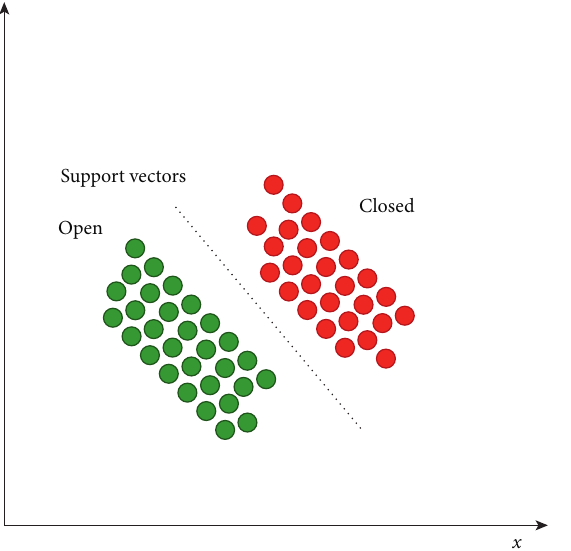
Figure 5: Support vectors